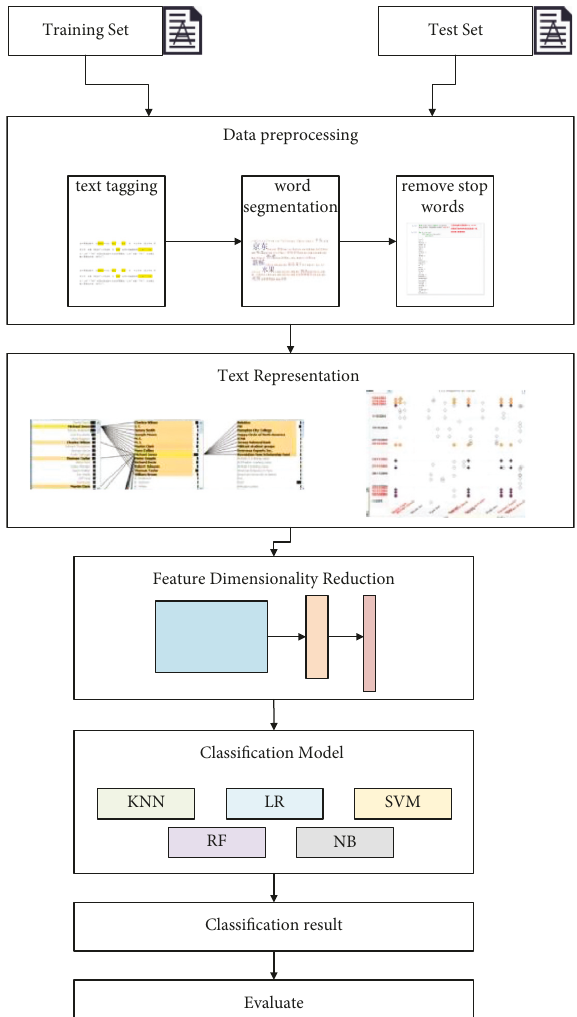
Figure 1: Flowchart of text